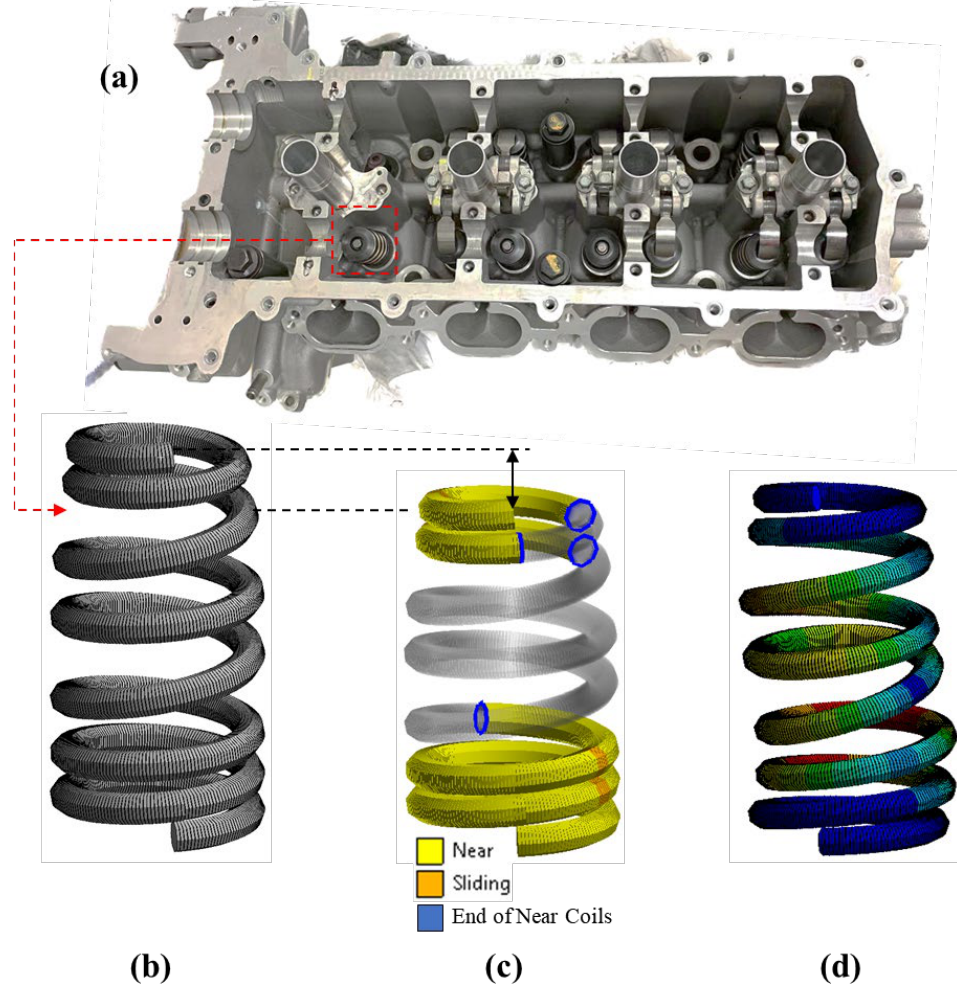
Figure 4. ( a ) The valve train system of a V8 sports car engine. ( b ) The FE spring model with a 0.4 mm element size and its ( c ) static and ( d ) dynamic status.